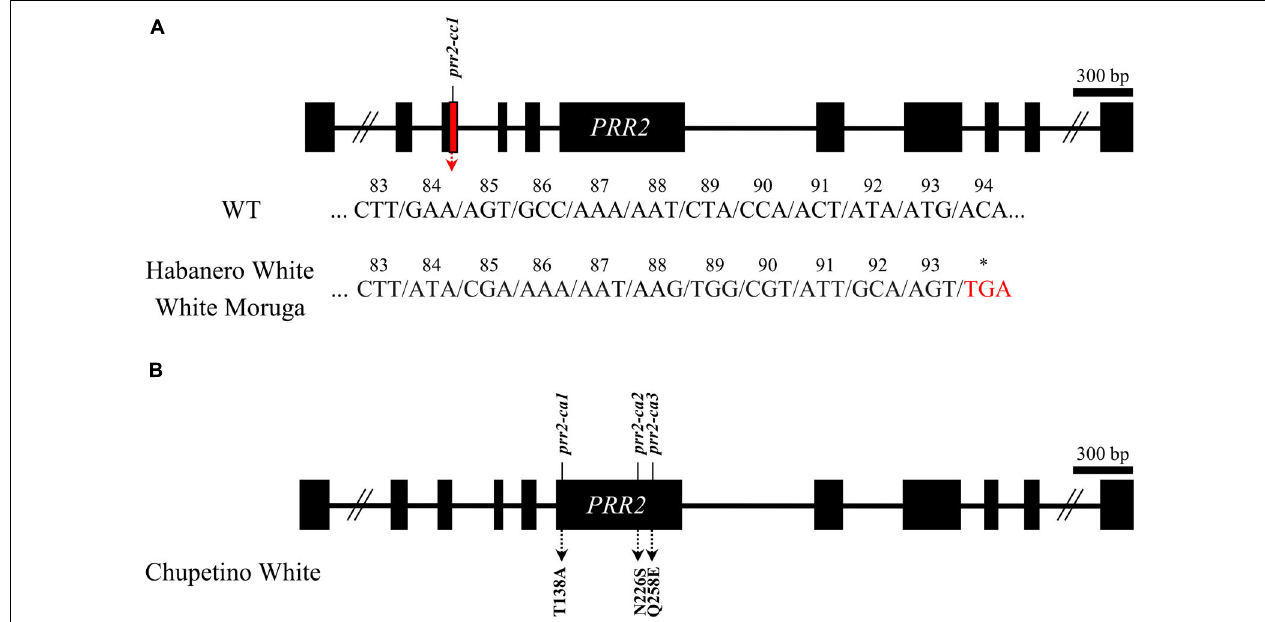
FIGURE 6 | Structural mutations of PRR2 in pepper cultivars with white mature fruit. (A) C. chinense ‘Habanero White’ and ‘White Moruga’ had same structural mutation leading to a premature stop codon. Consecutive non-synonymous mutations are shown in the figure. (B) C. annuum ‘Chupetino White’ had three non-synonymous substitutions. The amino acid substitutions are shown in the